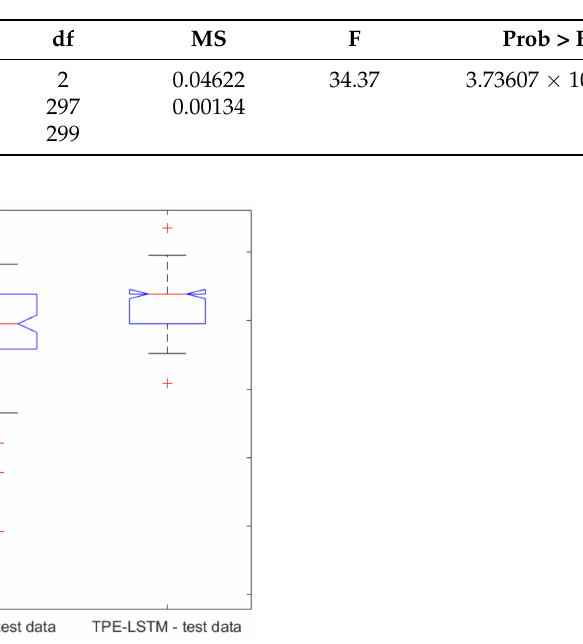
Table 5. ANOVA table.